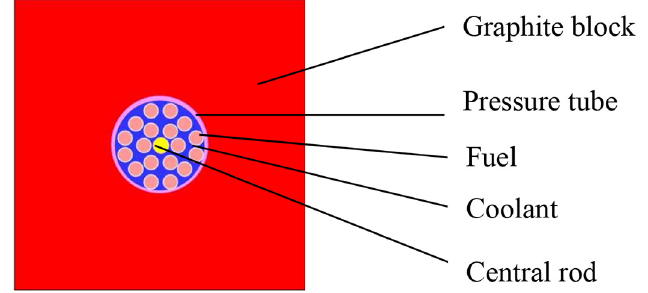
Fig. 3. Sectional view of FC.